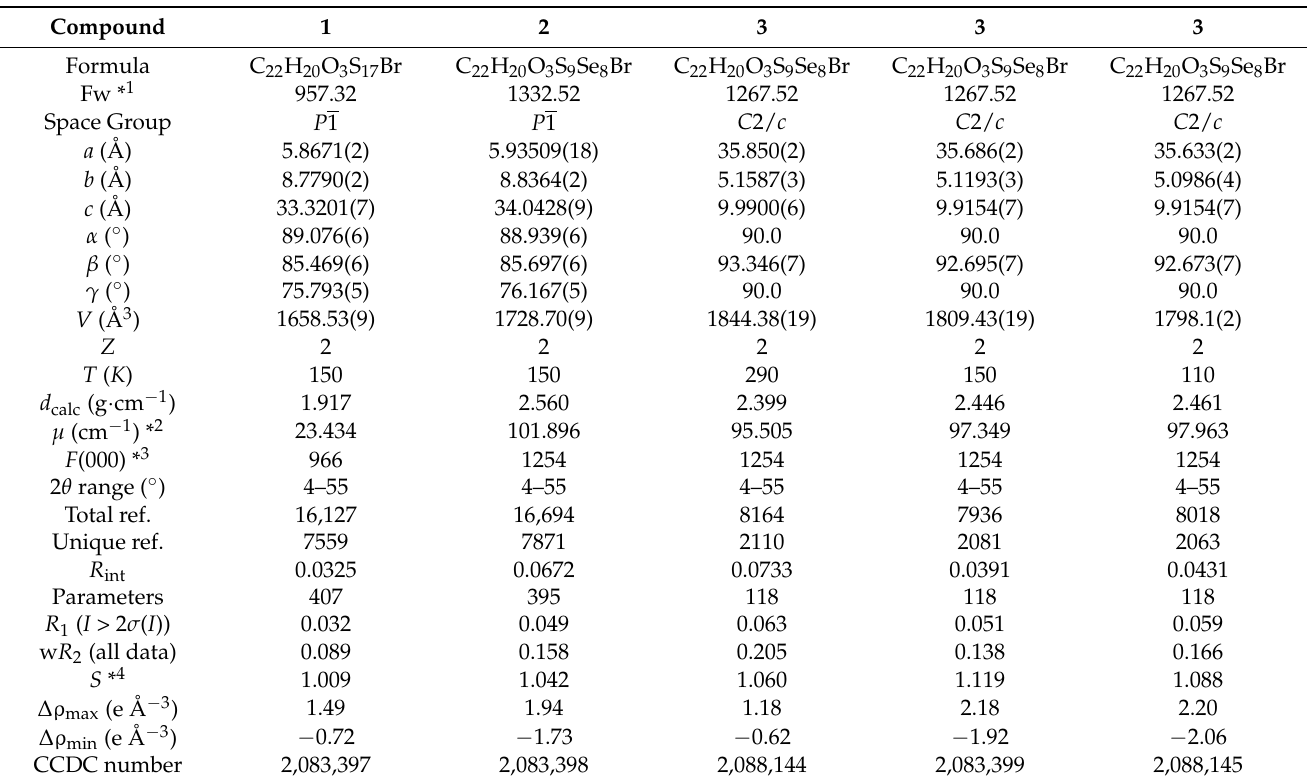
Table 1. Crystallographic data of 1 , 2 , and 3